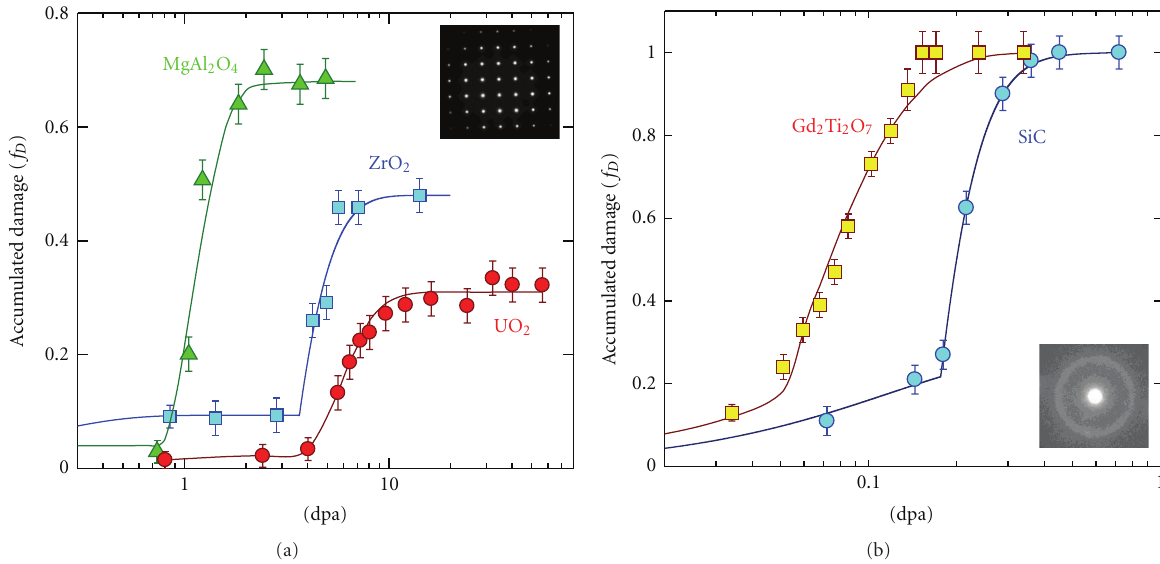
Figure 5: Accumulated damage ( f D ) versus ion fluence for nonamorphizable (a) and amorphizable (b) ceramics irradiated at RT with slow ions. Insets show TEM di ff raction patterns recorded at the final fluences on both types of